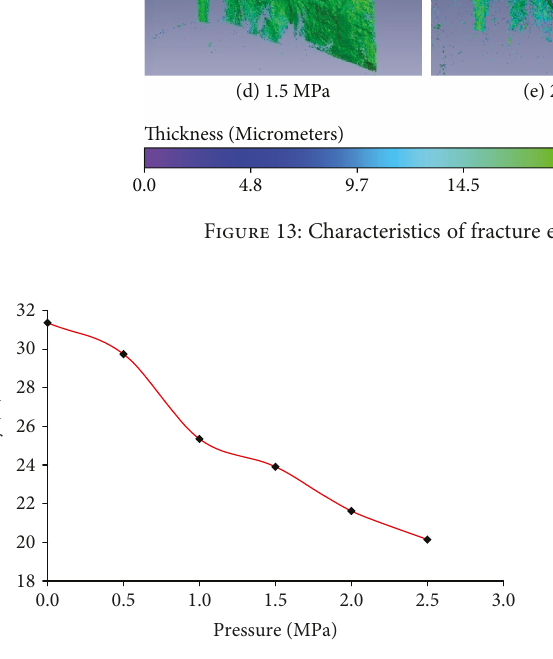
Figure 14: Porosity change of coal samples under di ff erent